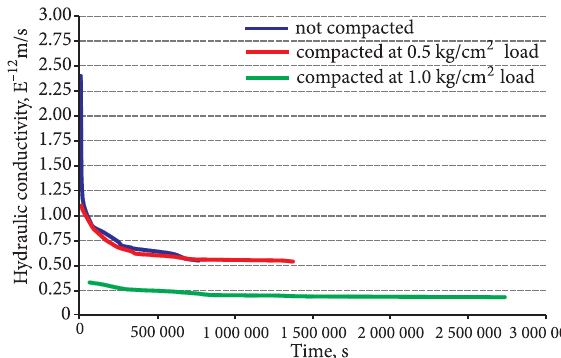
Fig. 3. Dependence on the hydraulic conductivity and the filtration time of natural structure clay